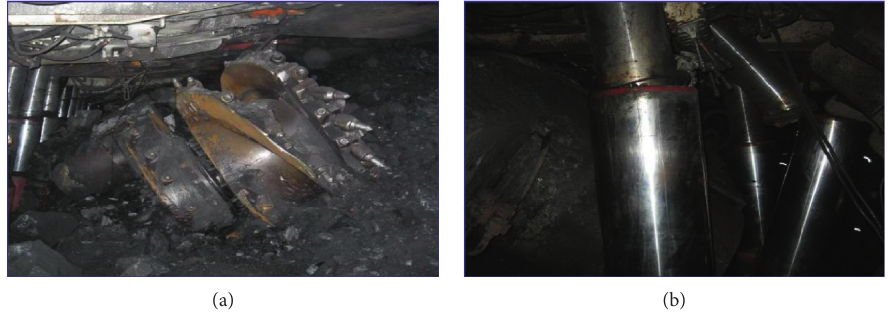
Figure 1: Actual situation of shock-type rockburst. (a) Toppling of shearer; (b) folding of single